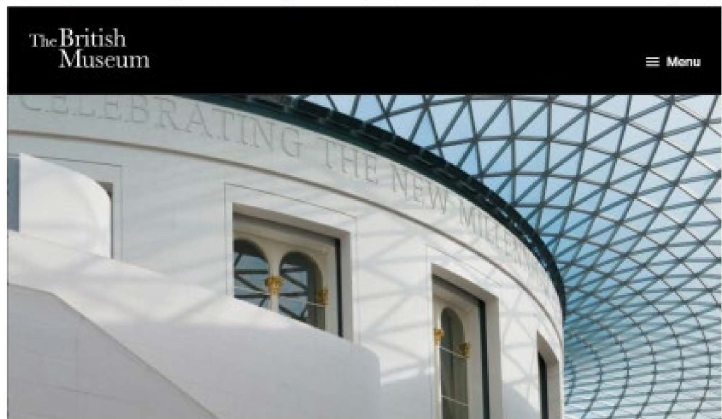
Figure 3. The website of the British museum today.